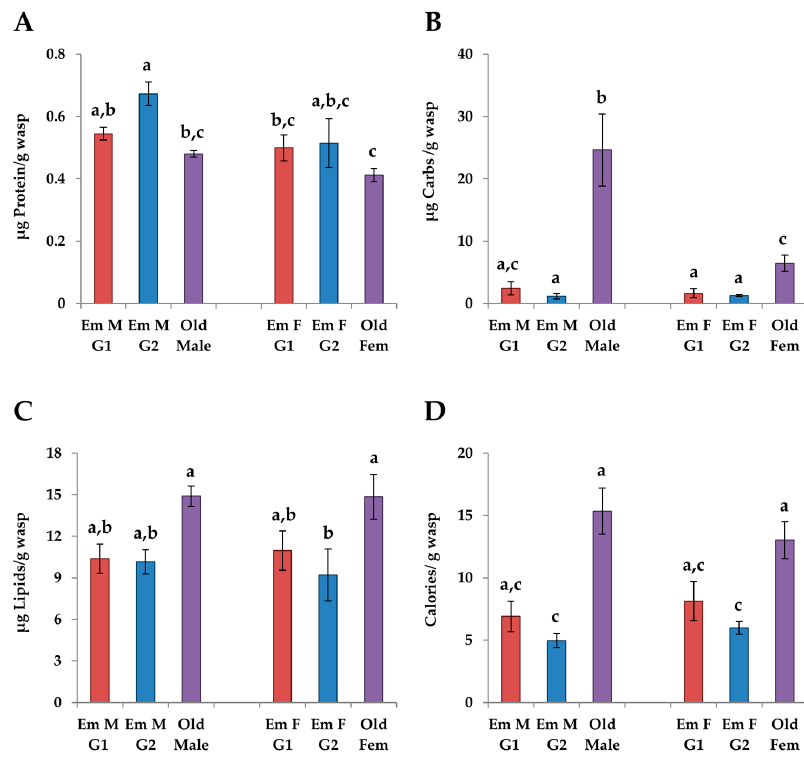
Figure 4. The mean levels of macronutrients: ( A ) protein; ( B ) carbohydrates; ( C ) lipids; and ( D ) calories per unit wet mass in eclosing males (N G1 = 6, N G2 = 4) and females (N G1 = 6, N G2 = 5) from the G1 and G2 generations and old adults (both generations combined, N Males = 8, N Females = 10) of Trypoxylon lactitarse . Error bars indicate standard error. For each graph, different letters (a–c) indicate significant differences between groups (MANOVA followed by THSD).